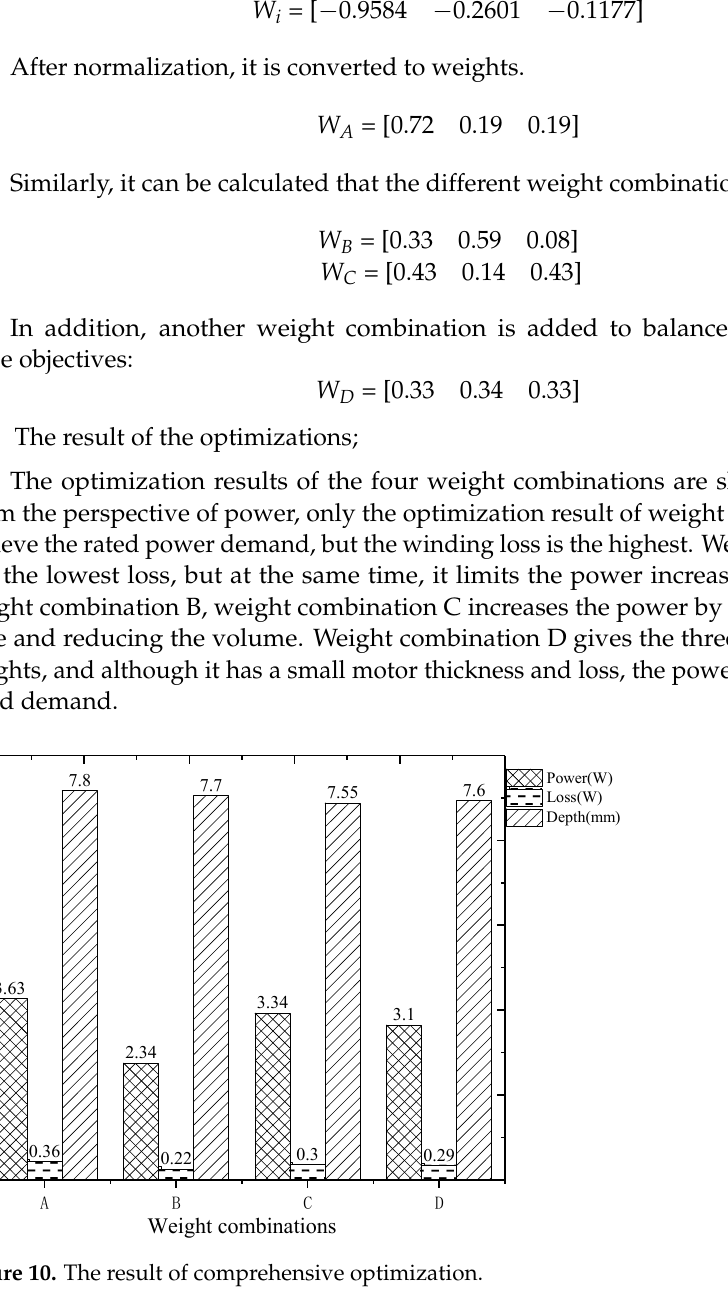
Table 8. The result of global optimization.